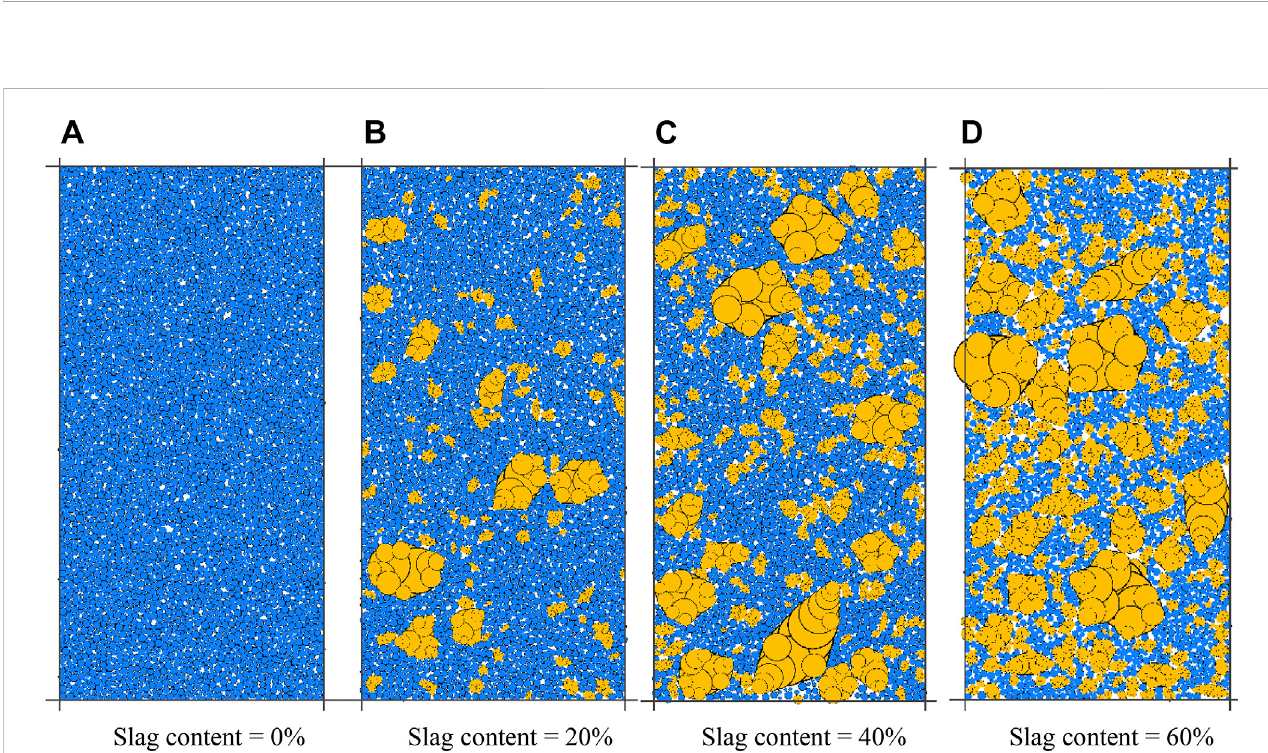
FIGURE 7 TSMspecimensindifferentslag contents(0% – 60%)generated byPFC-2D: (A) slag content =0%, (B) slagcontent =20%, (C) slag content =40%,and (D) slag content = 60%.